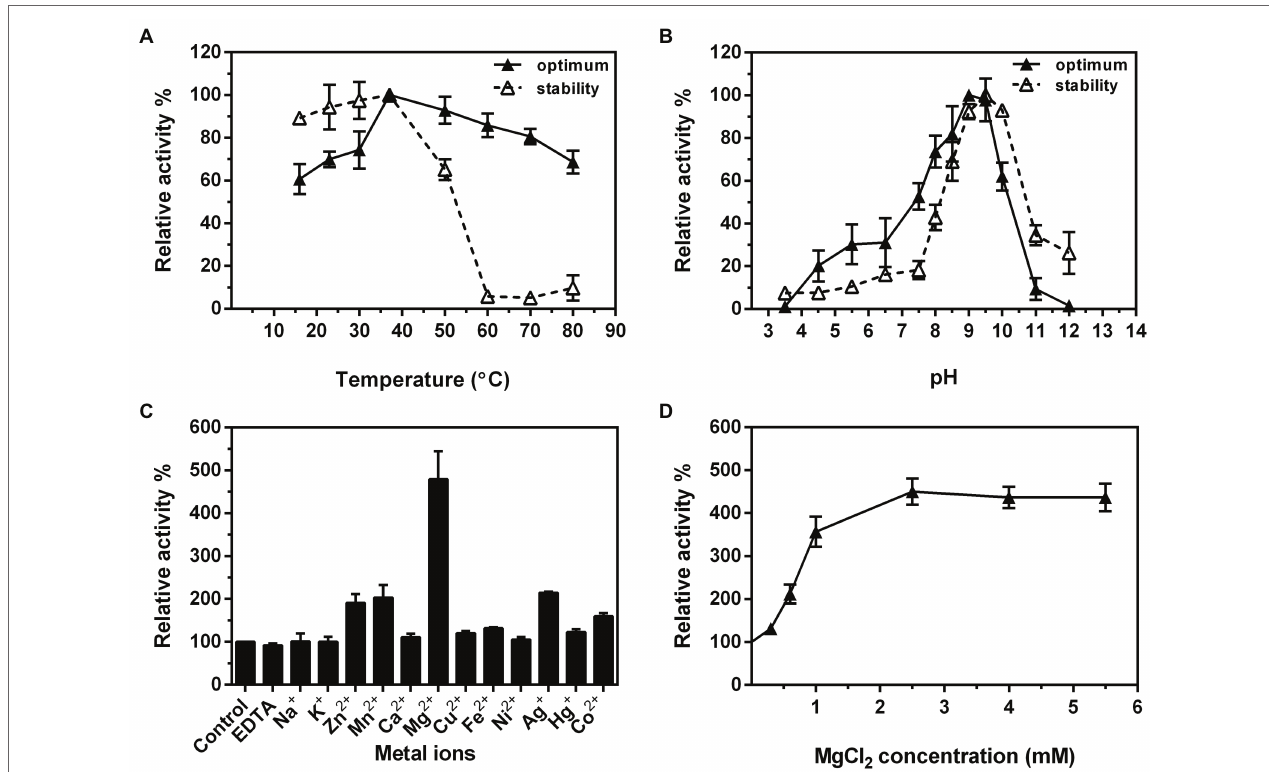
FIGURE 6 | Effects of reaction temperature (A) and pH (B) on the enzyme activity and stability of Ss-RmlA. Effects of metal ions (C) and concentration of MgCl 2 (D) on the enzyme activity of Ss-RmlA. Data points represent the means ± S.D. of three replicates.